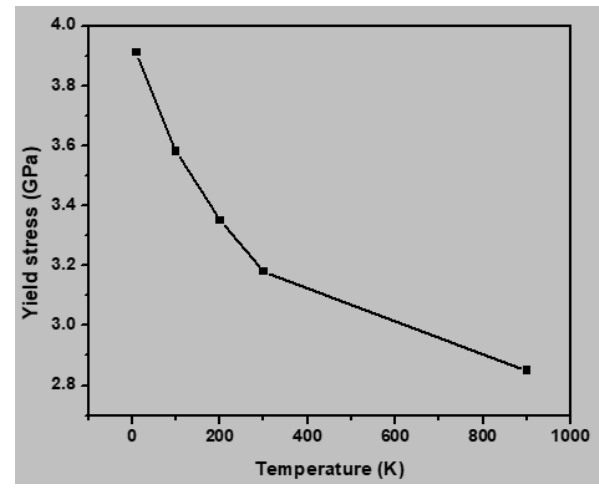
Figure 10. Stress–true strain curves for the nanocrystalline austenitic stainless steel sample with an average grain size of 2.5 nm at various temperatures.